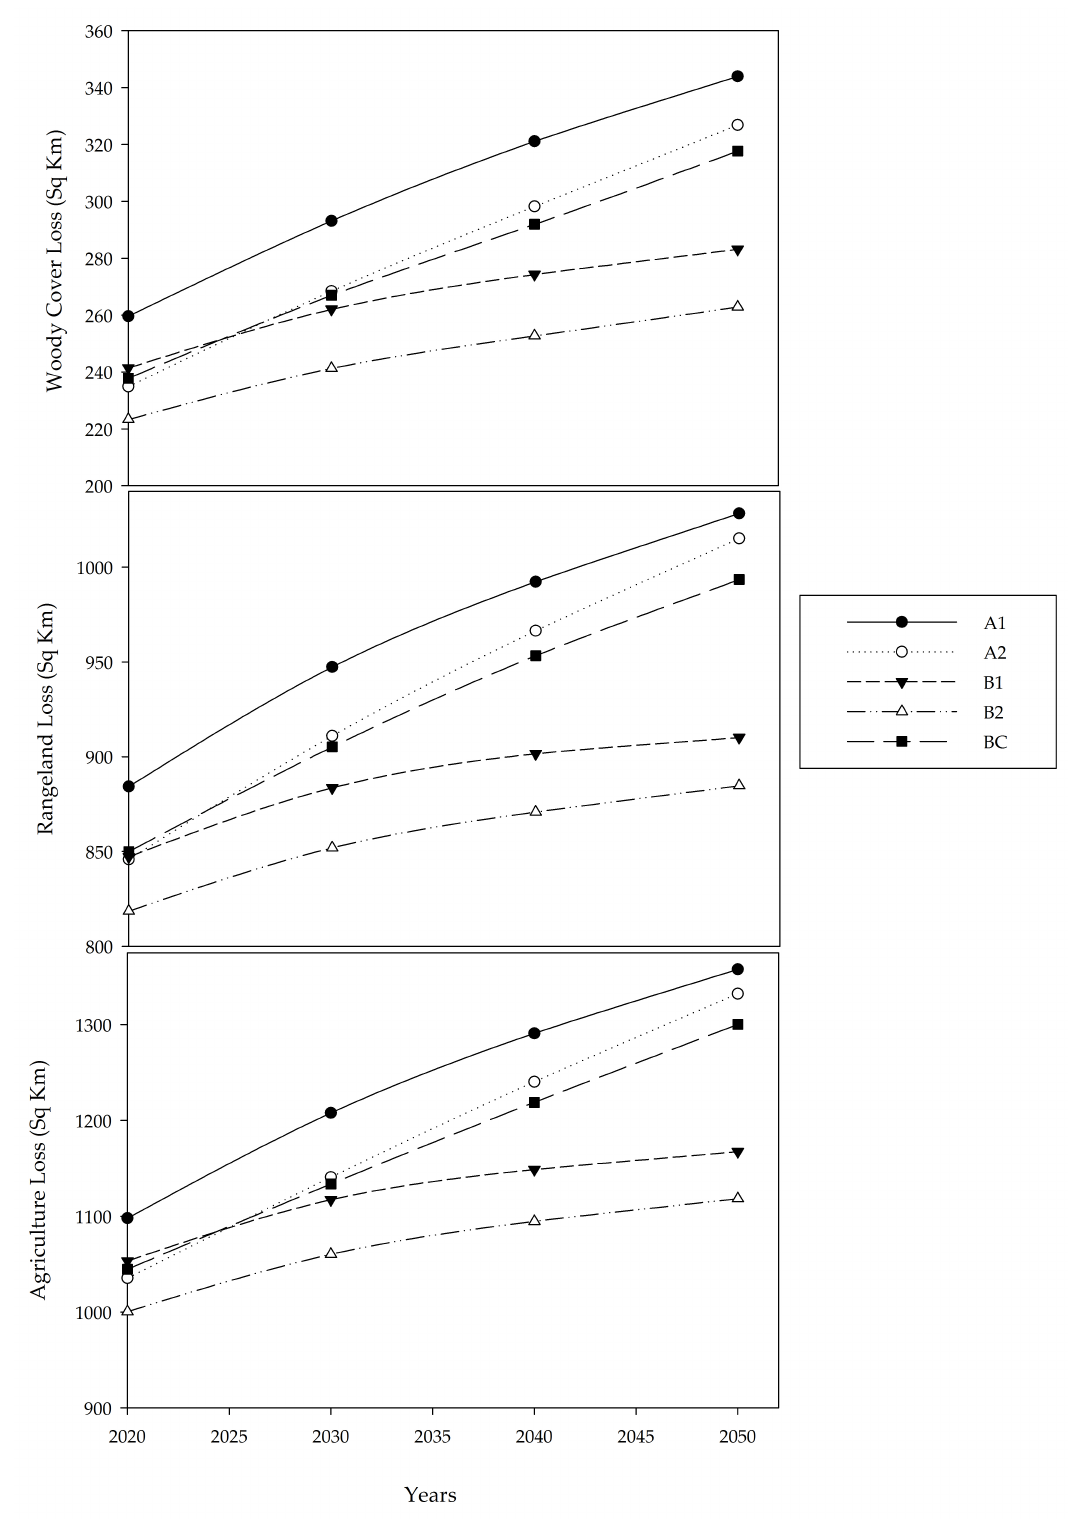
Figure 5. Projected losses (km 2 ) of woody, rangeland-herbaceous, and agriculture cover types from 2020 to 2050 for two economically-driven housing density scenarios (A1 and A2), two environmentally-friendly economic housing density scenarios (B1, B2), and a baseline scenario (BC) based on current LANDSAT imagery of the Rio Grande Delta and surrounding rangeland study area (10,065 km 2 ) in South Texas, United